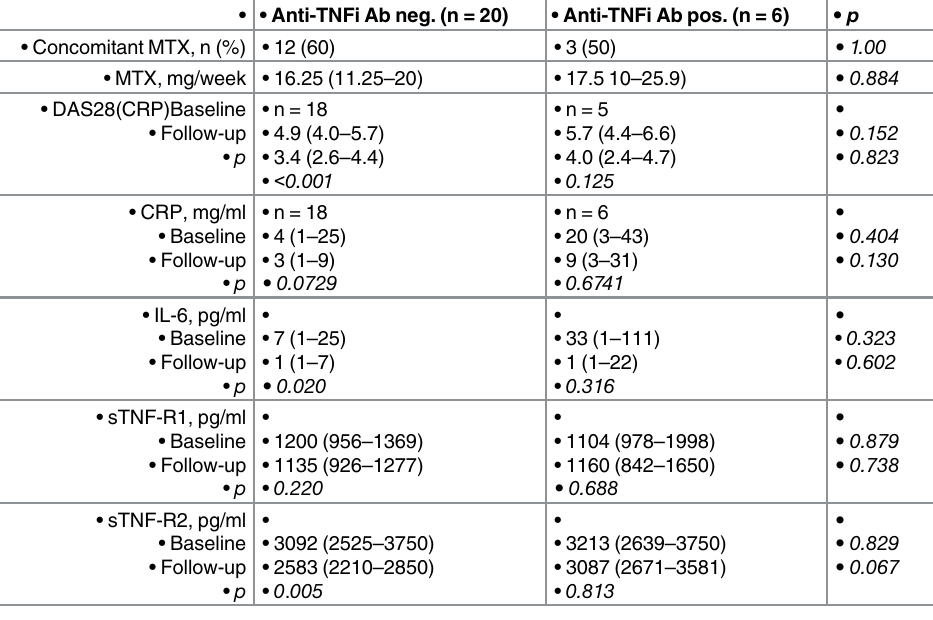
Table 3. Variables according to development of anti-TNFi Ab production following 6 months of treat- ment with adalimumab or infliximab. (cid:129) (cid:129) Anti-TNFi Ab neg. (n =